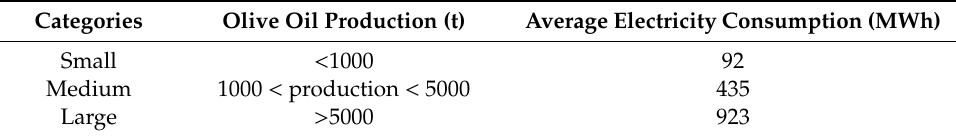
Table 1. Classification according to final olive oil production [12].